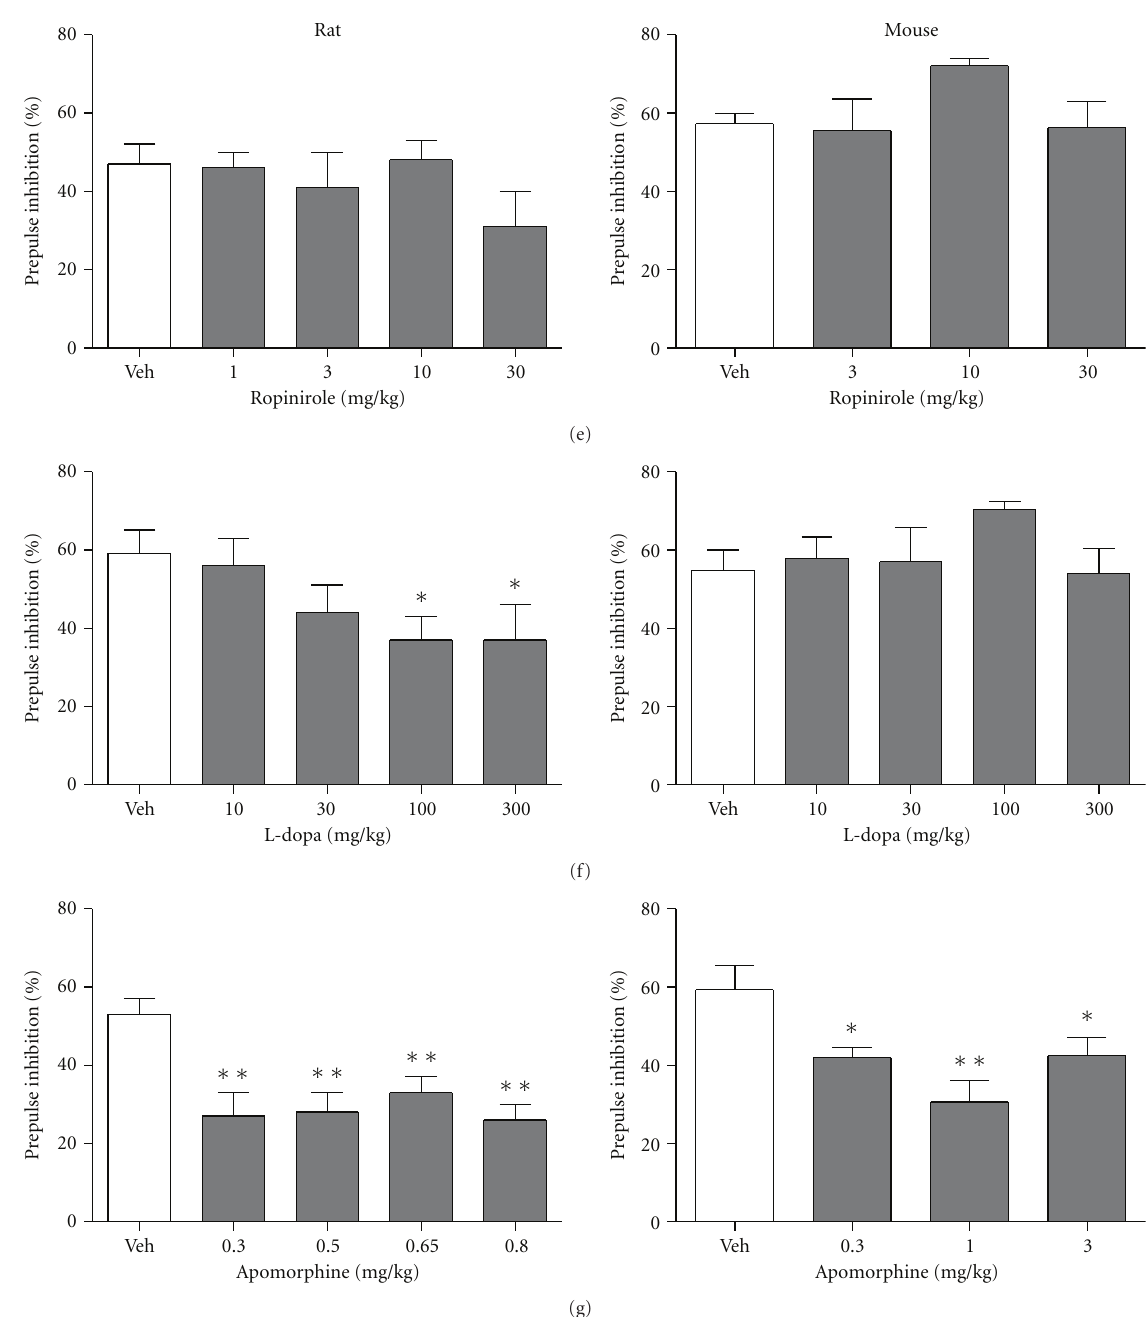
Figure 2: E ff ects of SCH 412348 (a), istradefylline (b), pramipexole (c), pergolide (d), ropinirole (e), L-dopa (f), and apomorphine (g) on rat (left) or mouse (right) prepulse inhibition. Data represent mean % PPI ± SEM and were analyzed by one-way ANOVAs with Dunnett’s tests ( ∗ P < 0 . 05; ∗∗ P < 0 . 01 versus vehicle